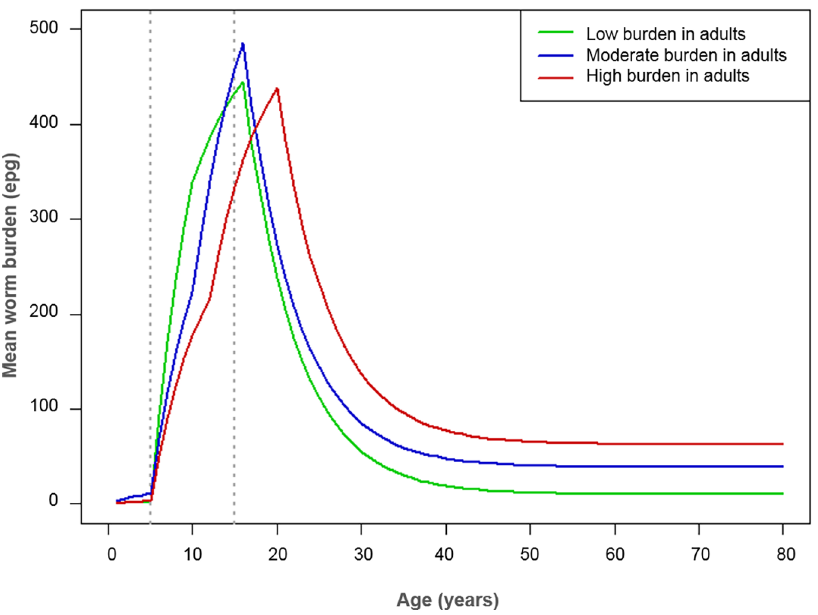
Fig 1. Age-intensity profiles of infection. Mean worm burden (eggs per gram of faeces, epg) across ages with low, moderate and high burdens of infection in adults relative to school-aged children (school-aged children are between 5–14 years of age and adults are 15+ years of age)